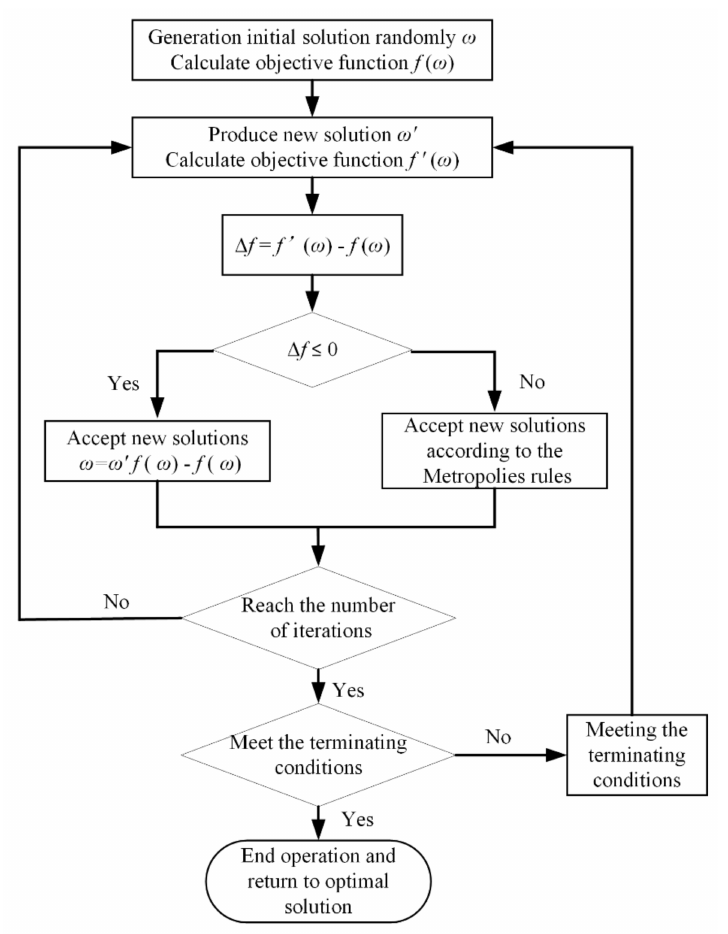
Figure 3. Flow chart of the advanced genetic algorithm